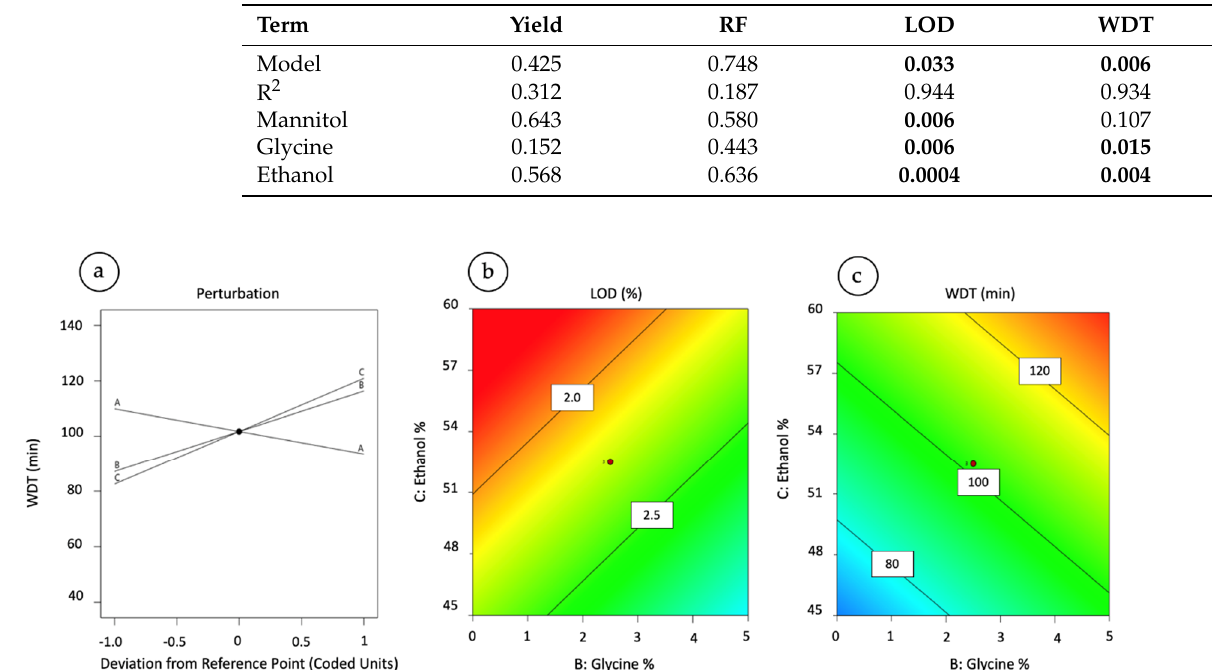
Figure 2. Perturbation graph of Weibull dissolution time (WDT) versus the critical factors plotted as deviation from the reference point (A = mannitol; B = glycine; C = ethanol) ( a ). Contour plot of LOD ( b ) and WDT ( c ) as a function of ethanol and glycine proportion in feed solution at the mannitol concentration of 15% ( w / w ).